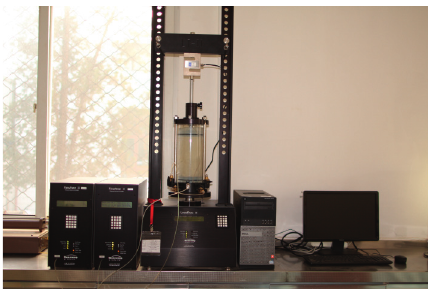
Figure 2: Large-scale direct shear apparatus